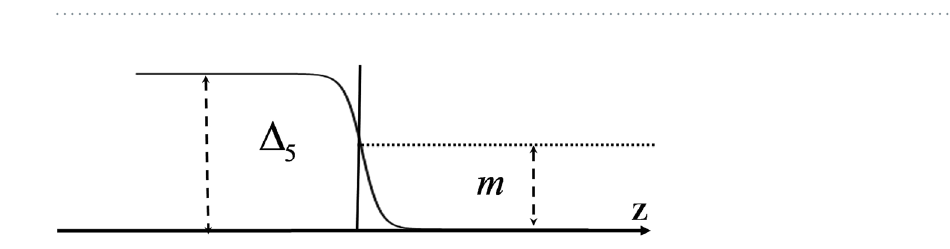
Figure 5. The Andreev bound states obtained for Josephson junction of part (b) in Fig. 1. These states show 4 π periodicity with respect to δφ which is an another direct signature of 2DMS.